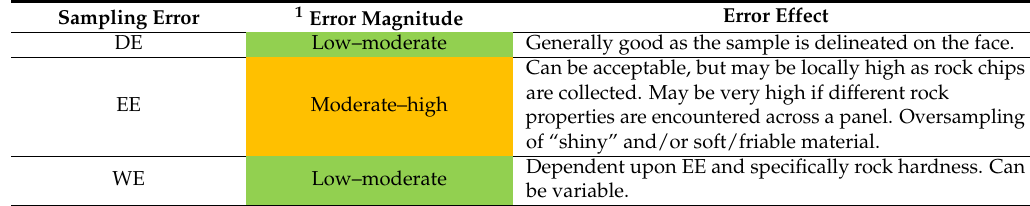
Figure 5. ( A ) Panel sample preparation. Large (100 kg) samples were required for metallurgical testing and grade verification; ( B ) Collecting panel samples with hammer and chisel. Samples were chipped from the drive sidewalls onto a plastic floor sheet; ( C ) Part of panel sample. Chip fragment size is reasonably well controlled, with a maximum fragment size of about 8 cm, and most below 5 cm. With samples collected from brittle material such as quartz there are a substantial proportion of sub-1 mm fragments present; ( D ) Alternate sample capture method using rubber mats. Table 12. Likely sampling errors during the collection of panel samples.